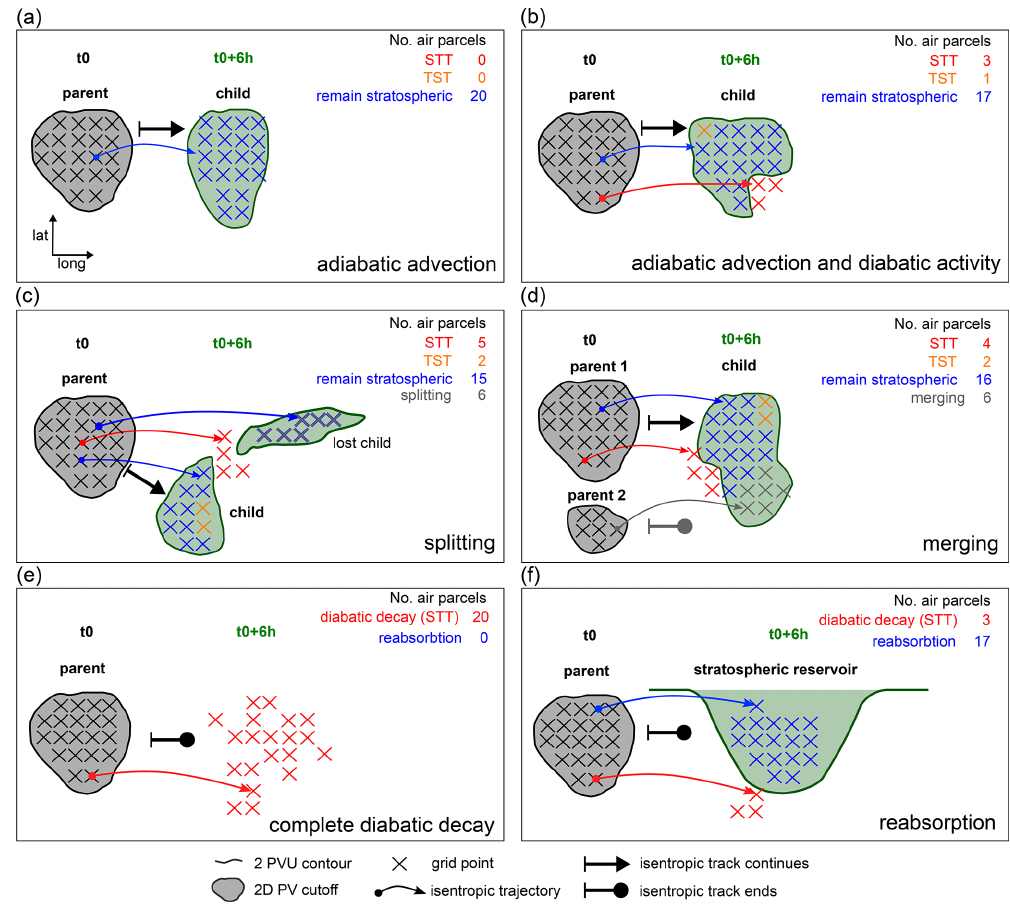
Figure 1. Schematic visualization of the tracking methodology and the associated quantification of STT, TST, diabatic decay, and reabsorp- tion on an isentropic surface in longitude–latitude space for situations with (a) perfect adiabatic advection of the PV cutoff, (b) adiabatic advection, and the presence of diabatic processes. (c) The same as (b) but with splitting; (d) the same as (b) but with merging, (e) complete diabatic decay, and (f) reabsorption with little diabatic decay. See text for a detailed discussion.